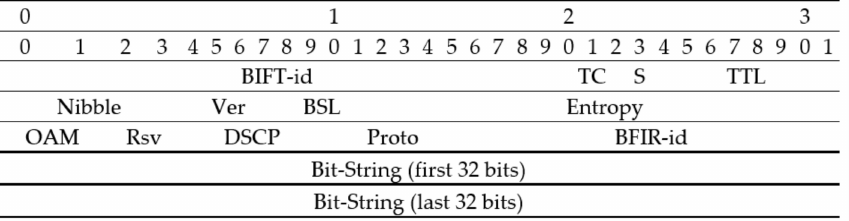
Figure 5. Bit Index Explicit Replication (BIER) header. BIFT-id—Bit Index Forwarding Table id. TC—Traffic Class. S—Not used in non-MPLS network. TTL—Time to Live. Ver—Version. BSL— BitString length. OAM—Optional bits. Rsv—Reserved. DSCP—Differentiated Services Code Point. Proto—Next Protocol. BFIR—Bit-Forwarding Ingress